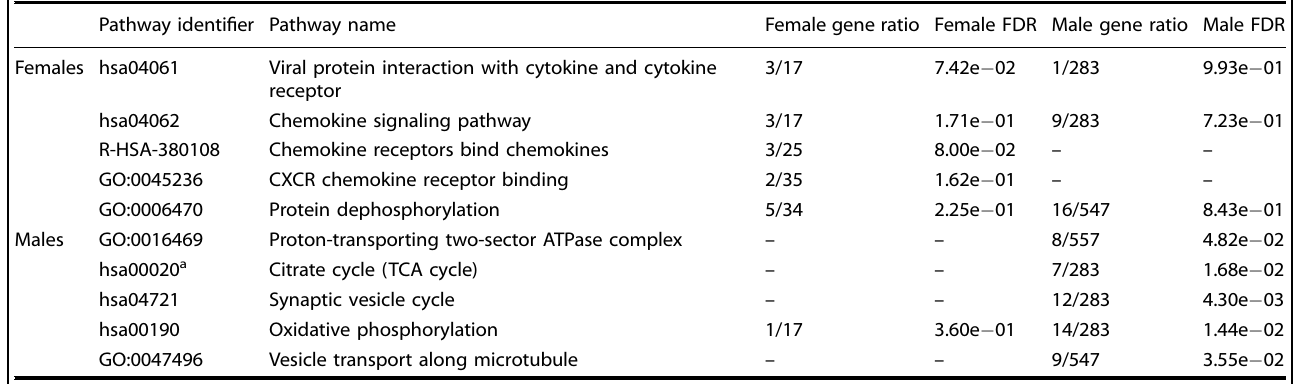
Table 2. Functional terms representative of the results of the functional enrichment